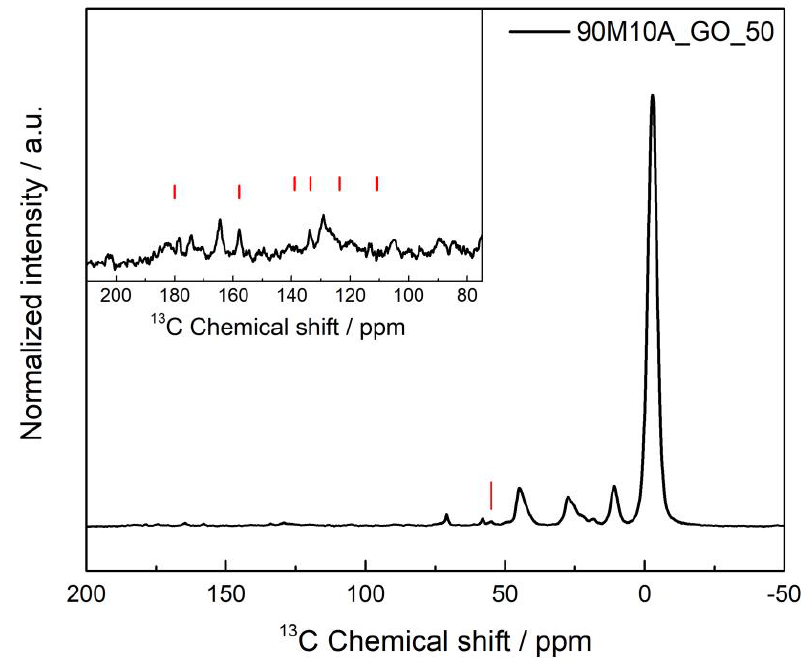
Figure 9. 1 H– 13 C heteronuclear solid-state NMR spectra of 90M10A_GO_50 after the adsorption process of naproxen. The red lines indicate the detected NPX peaks. The inset shows a vertical expansion of the spectral range where the NPX peaks are present.